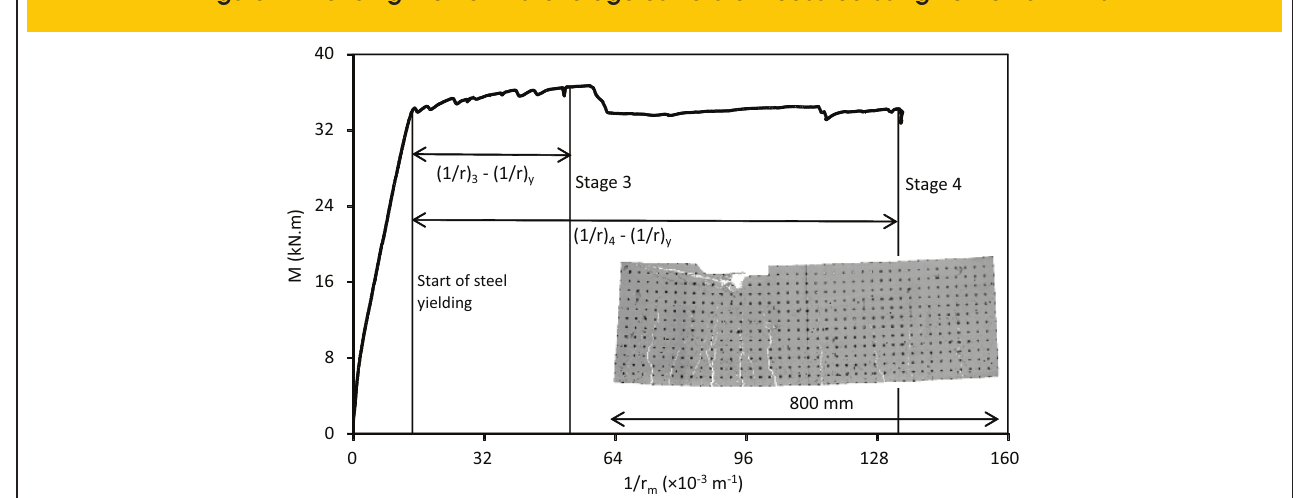
Figure 9 – Bending moment vs. average curvature measured using horizontal